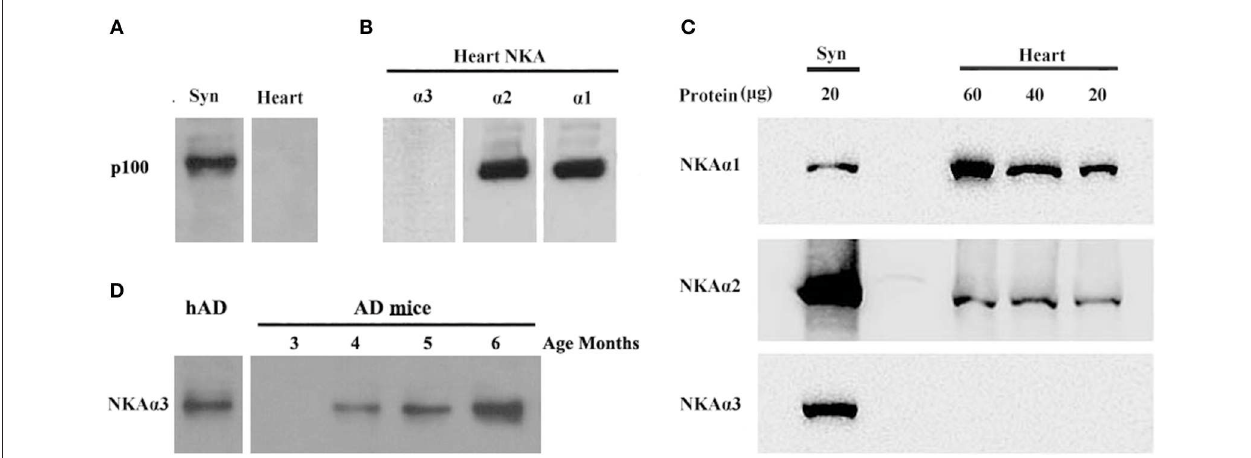
FIGURE 7 | A β Os selectively bind NKA α 3 in brains not in hearts of mice and at early stage of 3 × Tg AD mice. (A) Mouse brain synaptosome membranes and mouse heart membranes were assayed for A β O binding proteins by ligand blots. Oligomers of A β selectively bind p100 in brain not in heart cell membranes. (B) Western blots of heart cell membranes show minimal NKA α 3 related to α 1 and α 2. (C) Western blots showing relative abundance of NKA α 1 and α 2, not α 3 proteins in synaptosome compared to heart cell membranes (assayed at 20, 40, 60 µ g protein). (D) A β O ligand blot showing the soluble A β Os, extracted from 3 × Tg mice, binding to NKA α 3 (assayed 3, 4, 5, 6 months old). Overall, results show p100 in mouse also is NKA α 3, which is much more abundant in brain than heart, A β Os could bind to NKA α 3 in early stage of